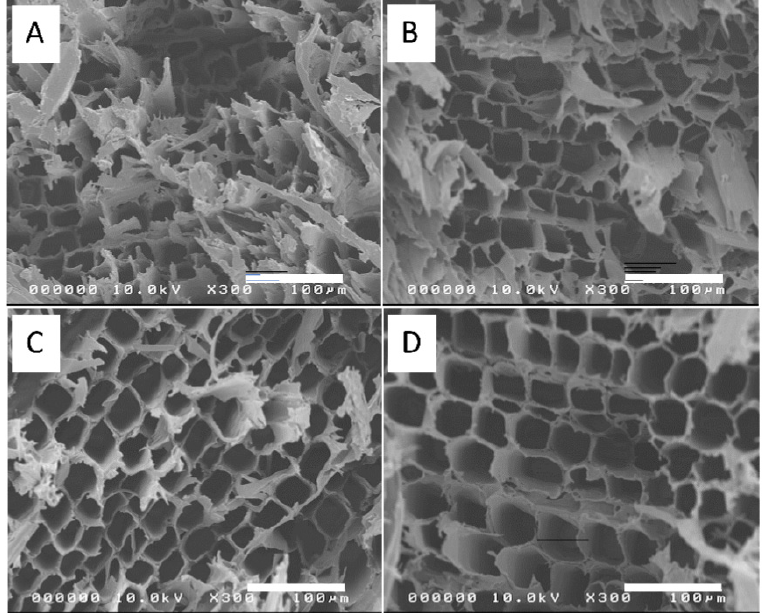
Figure 2. Cross-sectional FESEM images of bleached wood specimens before compression: ( A ) B1,